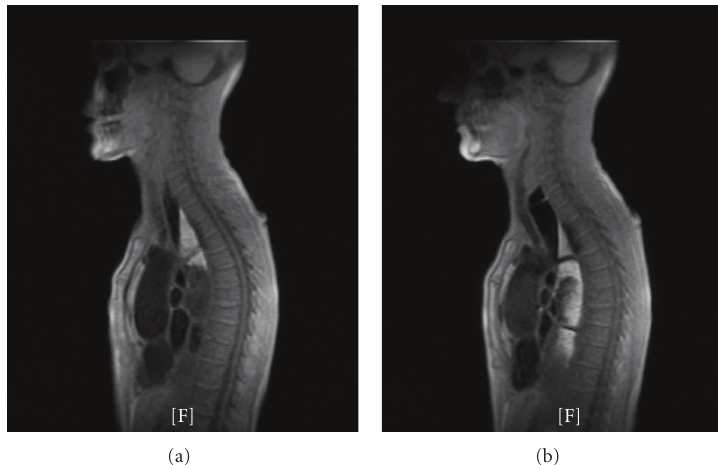
Figure 2: Advanced achalasia. Images acquired at 5sec (a) and 20sec (b) after bolus administration show distension of the oesophageal lumen ( > 60mm) and replacement of the normal peristalsis by tertiary activity. The bolus does not progress into the stomach due to LES abnormalities.